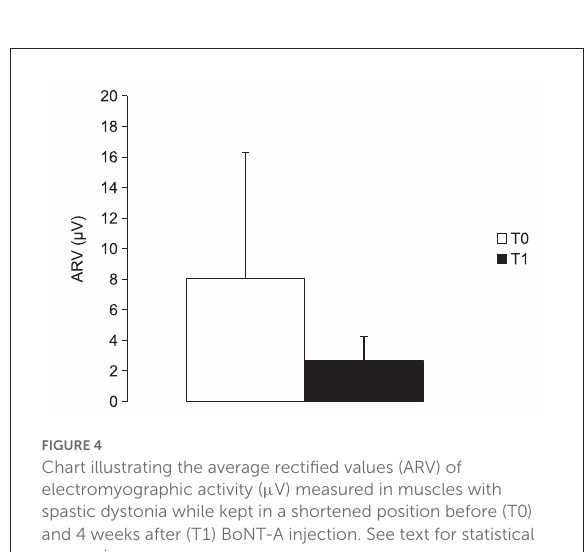
FIGURE4 Chart illustrating the average rectified values (ARV) of electromyographic activity ( µ V) measured in muscles with spastic dystonia while kept in a shortened position before (T0) and 4 weeks after (T1) BoNT-A injection. See text for statistical